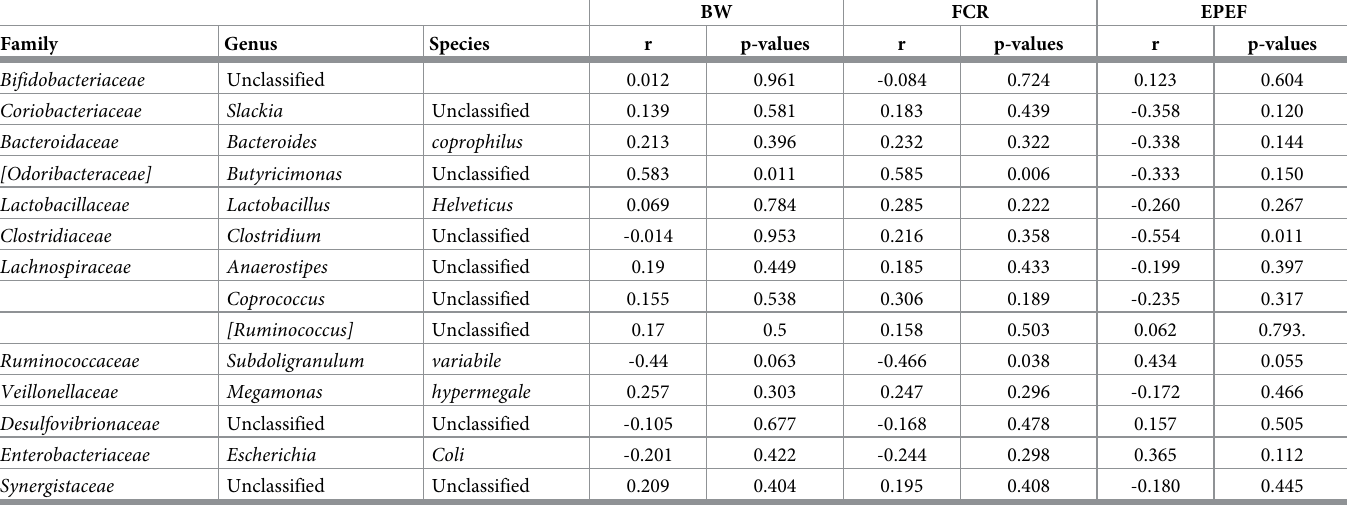
Table 8. Cecal microbiota composition correlated with productive indicators (Experiment